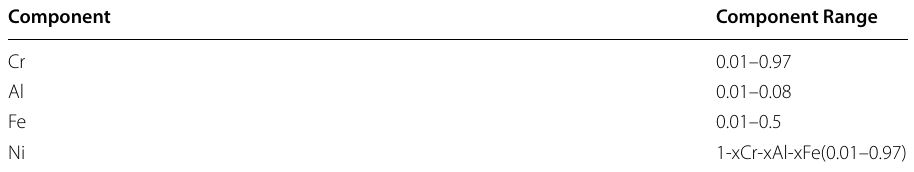
Table 3 Composition range covering the BCC/FCC two-phase range over which the Gibbs free energy densities data were fitted